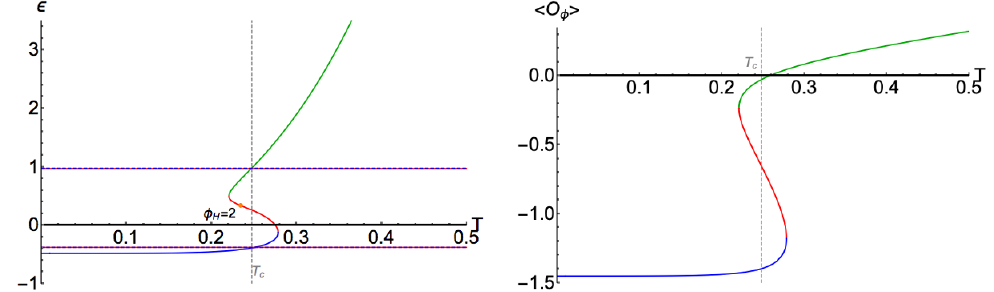
Figure 2 . Energy density (left panel) and the expectation value of the operator dual to the bulk scalar (cid:12)eld (right panel) for a system of class A [16]. The indicated point (cid:30) H = 2 is used as an initial con(cid:12)guration for time